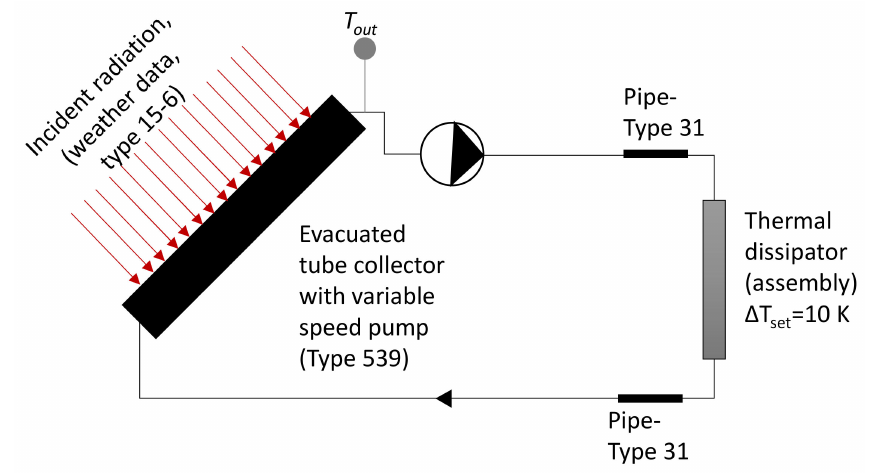
Figure A1. Schematic layout of TRNSYS model realized for heat available calculation.